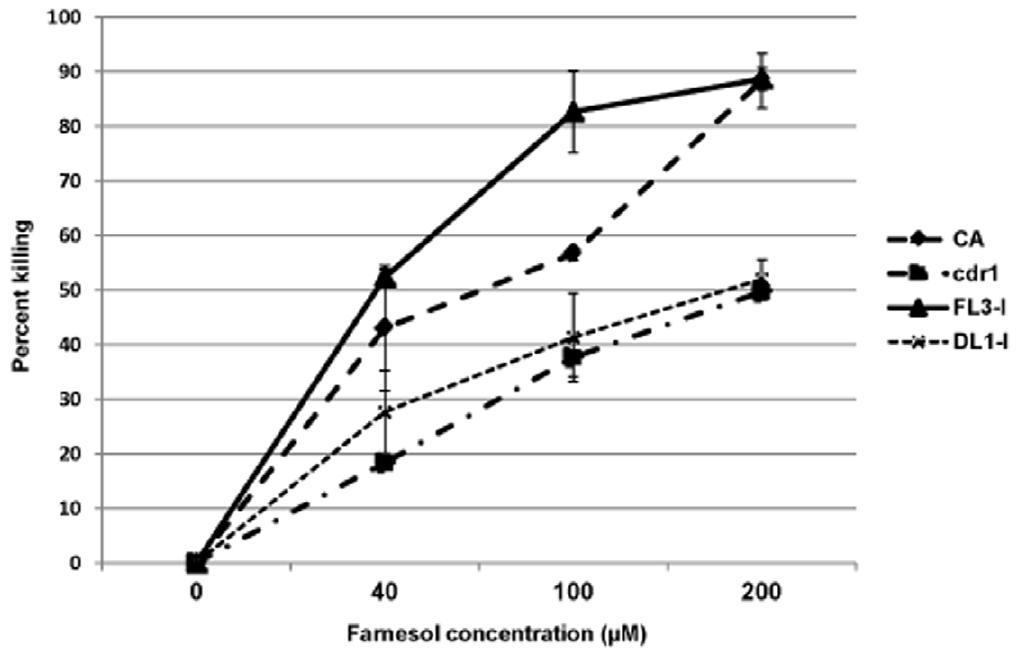
Figure 3. Effect of CDR1 overexpression on the response to farnesol toxicity using the MTS viability assay. Significant increase in susceptibility to farnesol in FL3 strain following induction of CDR1 overexpression with the strains lacking the CDR1 gene demonstrating enhanced tolerance. Error bars indicate the standard errors of the means. p , 0.05.